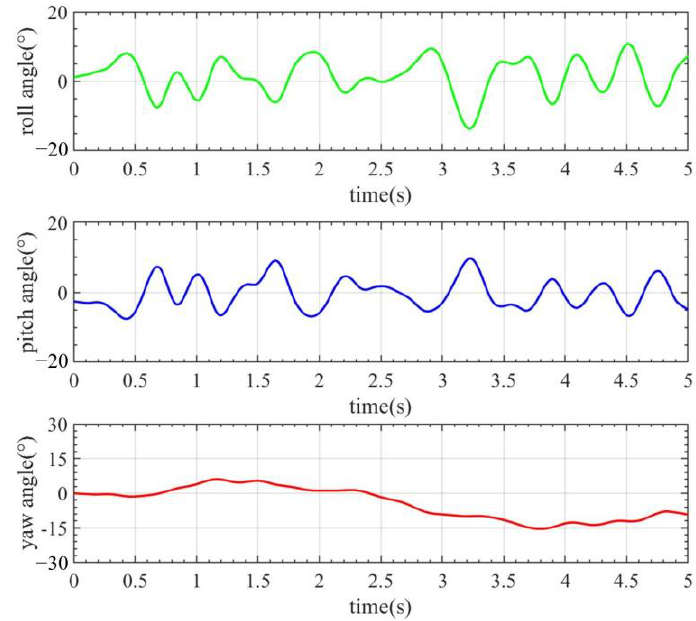
Figure 20. Attitude angle when the FMAV hovers in the air.